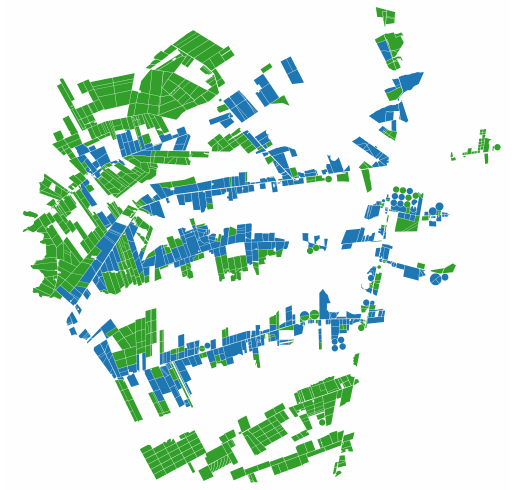
Figure 7. Reference crop parcels in LEM 19/20 dataset. Blue polygons were used for training the Baseline 1. Green polygons were used for testing the proposed networks.